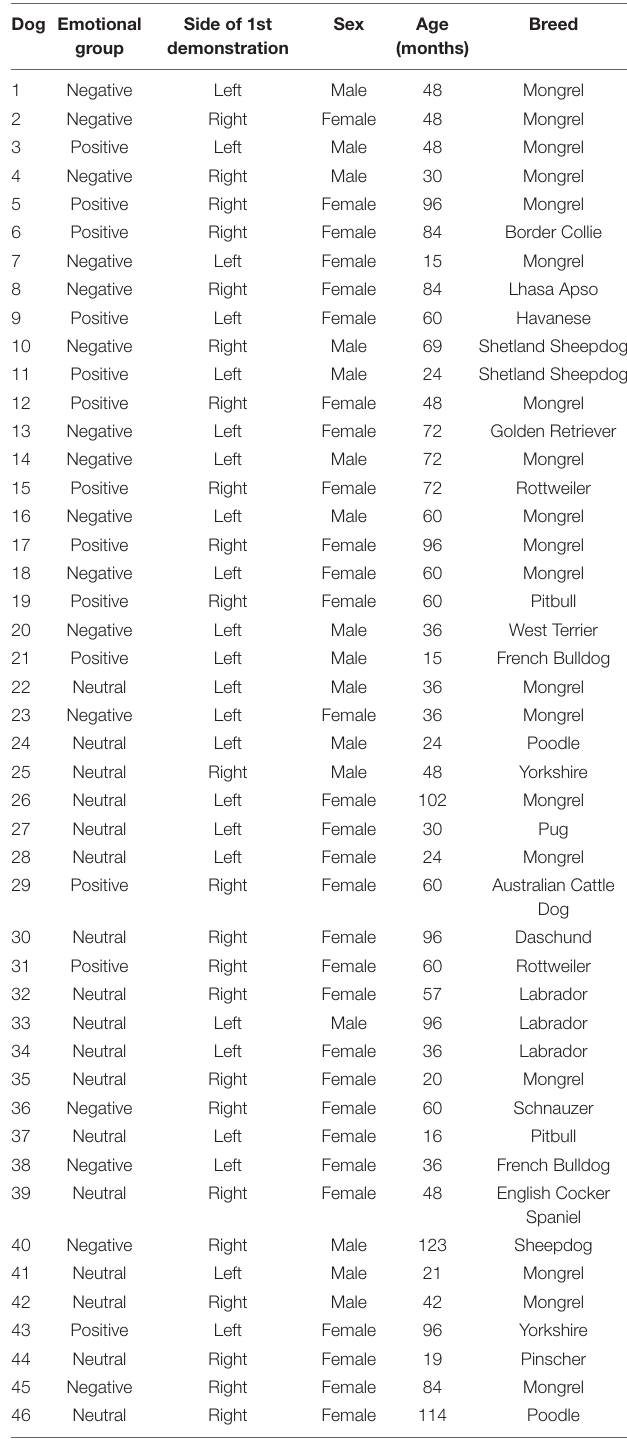
TABLE 1 | Information of the sample of dogs analyzed. Dog Emotional